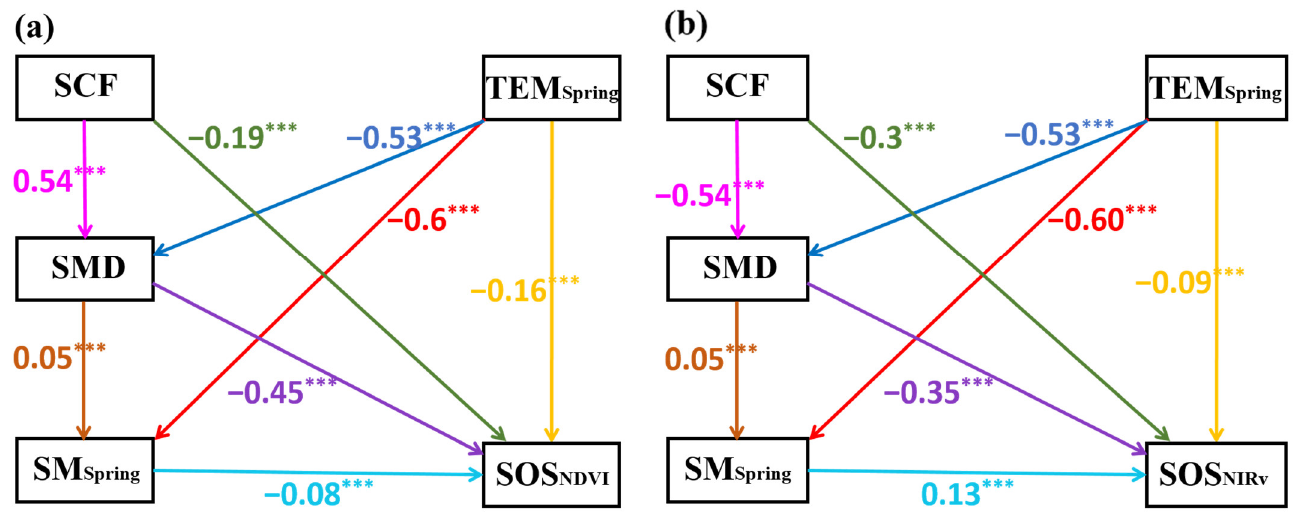
Figure 10. Path analysis of SOS NDVI ( a ), and SOS NIRv ( b ), for each influencing factor. *** indicates that the path coefficient is extremely significant, p < 0.01.